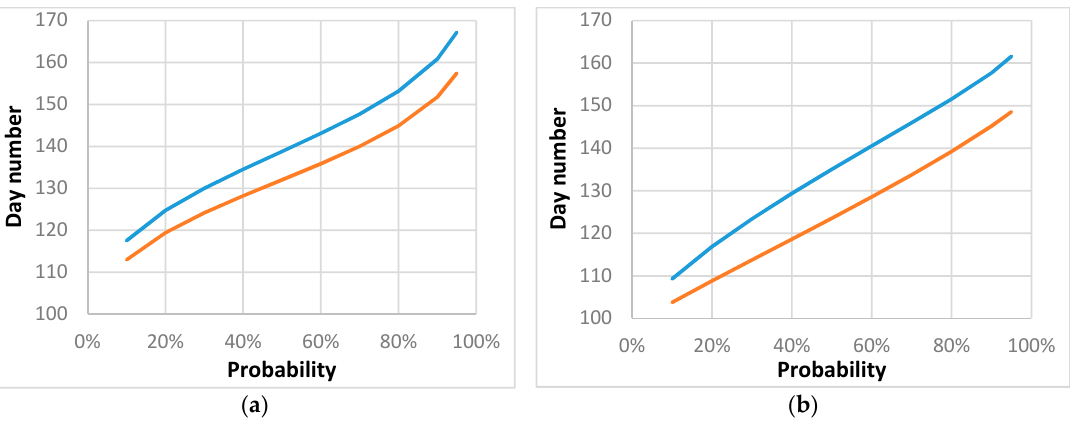
Figure 8. The probability curves of the last spring frost event described by a calendar day number ( Tmin < 0 °C) in the period of 1961–1990 (blue line) and 1991–2020 (orange line). ( a ) Poznan, ( b ) Kalisz. For 2 stations—Wielichowo (Figure 9a) and Lublin (Figure 9b)—around the day, which ended the frost period with 80% probability, the probability curves intersected, and so for the later date of the last frost, the probability was higher in 1991–2020.